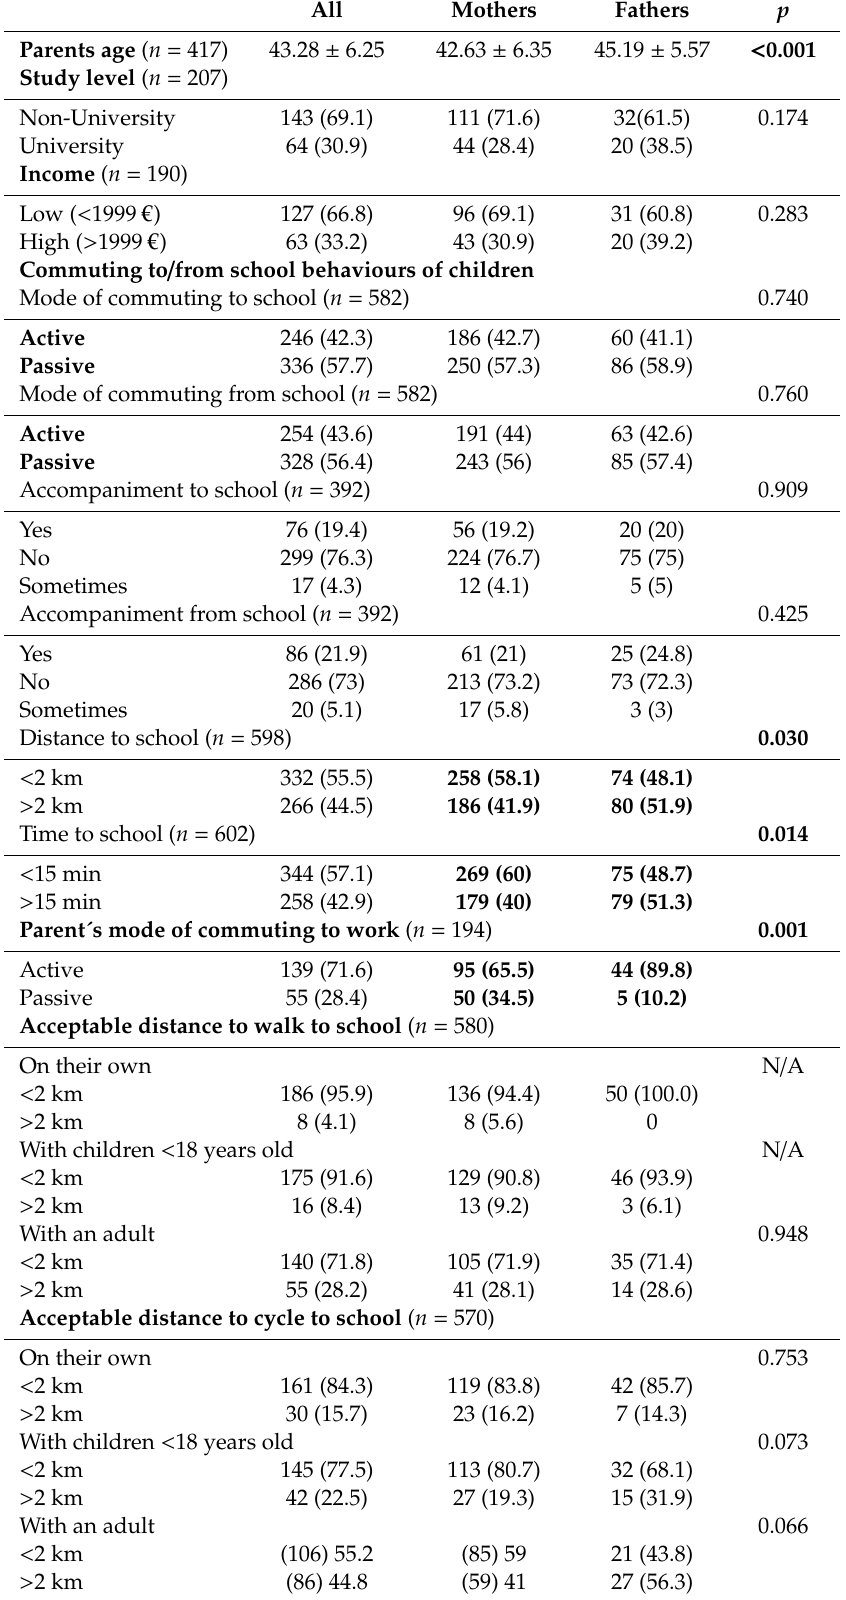
Table 2. Descriptive data of the “Family commuting-to-school behaviour” questionnaire and sociodemographic characteristics of the parent’s sample according to